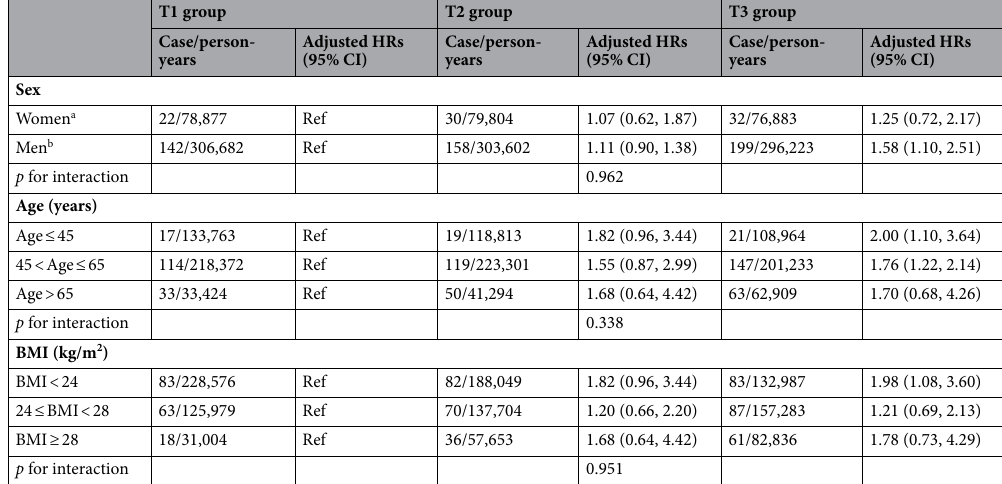
Table 3. Subgroup analysis of the association of SUA with the risk of CRC. All models were adjusted for age, sex, BMI, TG, TC, CRP, TBIL, ALT, diabetes, hypertension, family income, educational background, marital status, salt consumption, current smoker, drinking status, physical activity, chronic kidney disease, and family history of cancer except the stratified factors. a The cut-offs of the SUA among females were 211.00 and 267.00 μmol/L, respectively. b The cut-offs of the SUA among males were 262.00 and 329.00 μmol/L,